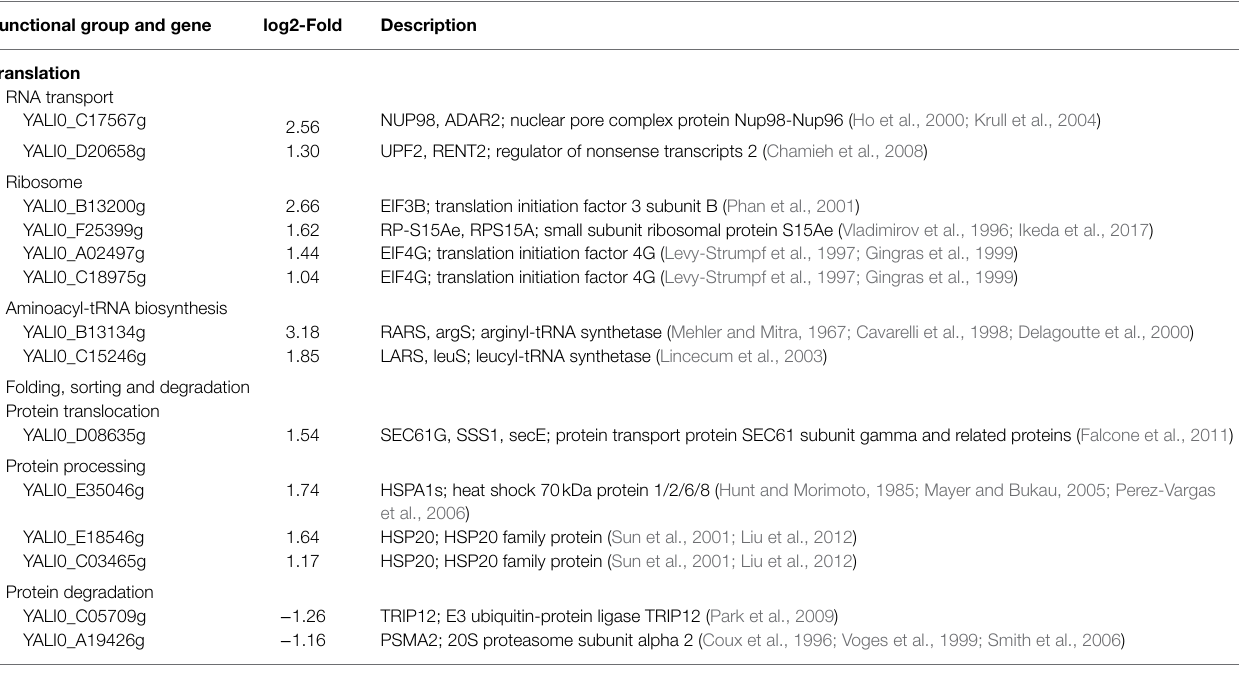
TABLE 1 | The differentially expressed genes in the folding, sorting and degradation and translation gene sets. Functional group and gene